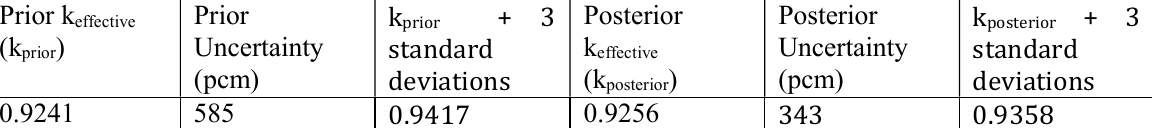
Table III.: Prior and Posterior Statistics using 13 Experimental Configurations